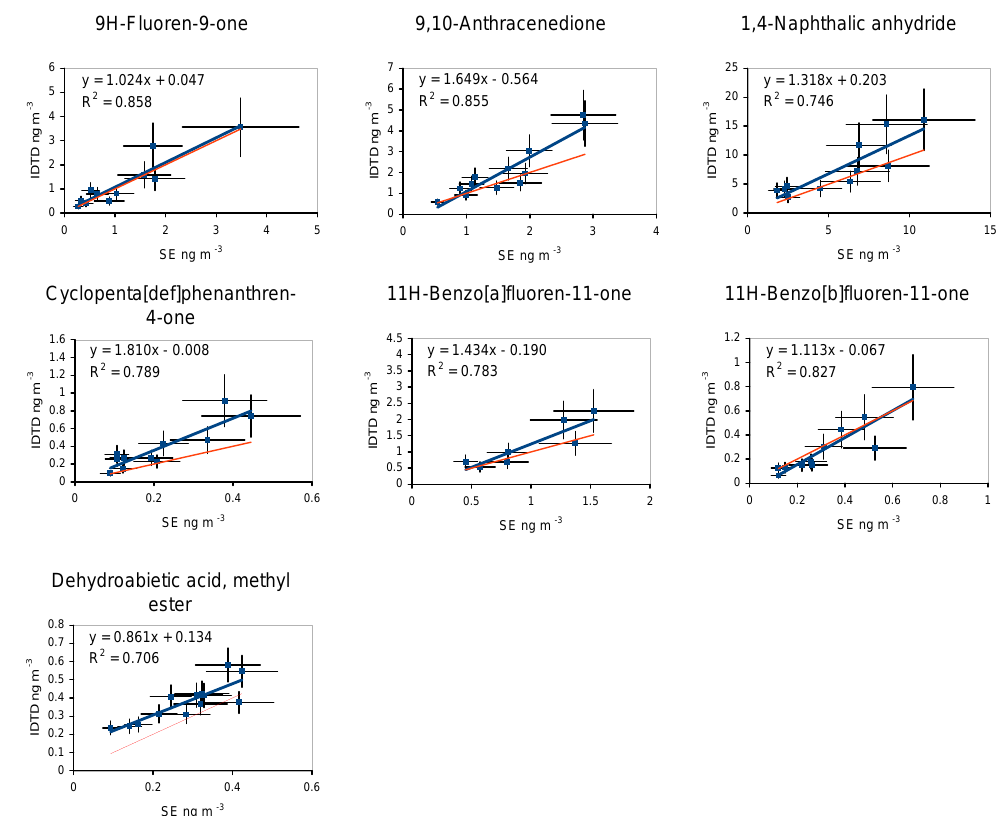
Fig. 5b. Correlation of IDTD and SE for analysis of o-PAH and dehydroabietic acid methyl ester in ambient aerosol samples (blue: linear regression, red: line through origin, slope